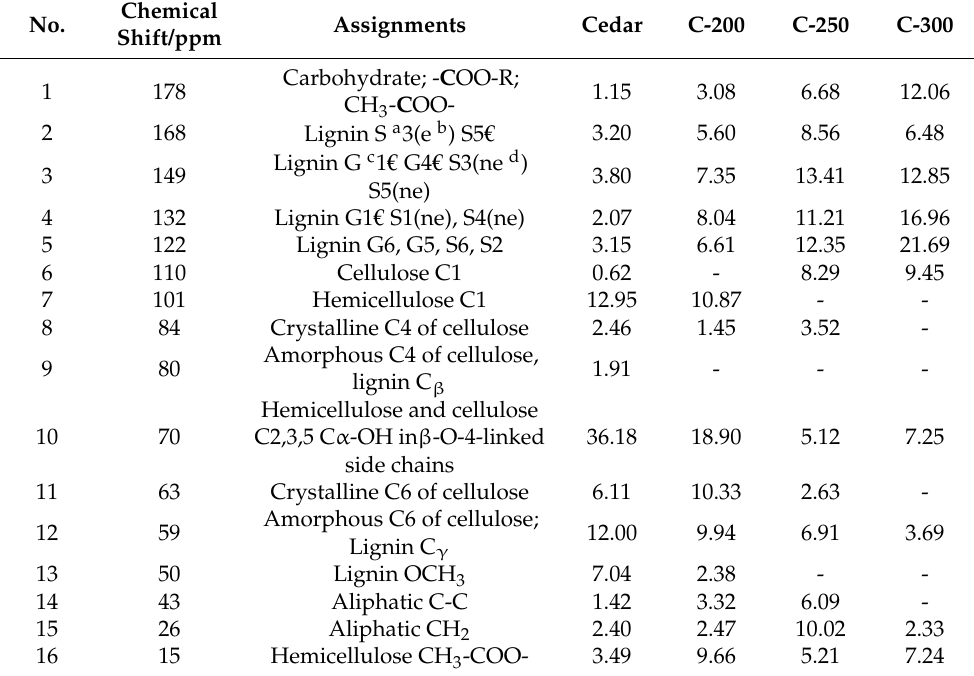
Table 3. Main carbon structure assigned at chemical shift with area percentage of raw and tor- refied